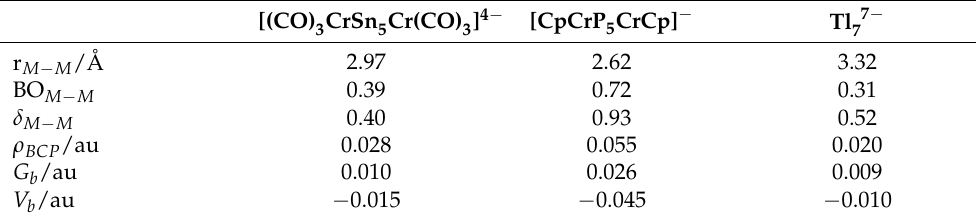
Table 2. Comparison of Mayer bond orders (BO) and QTAIM parameters for the trans -Annular M-M Bond Critical Points (BCPs) for 28-electron M and Tl 7 − 7